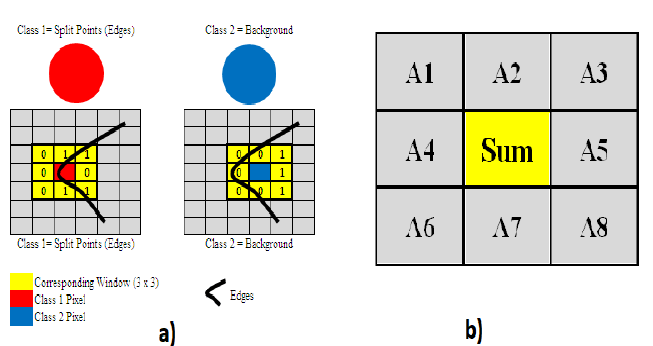
Figure 8. ( a ) Concept of two classes. Class 1 belongs to the edges and Class 2 belongs to the background. ( b ) Neighborhood